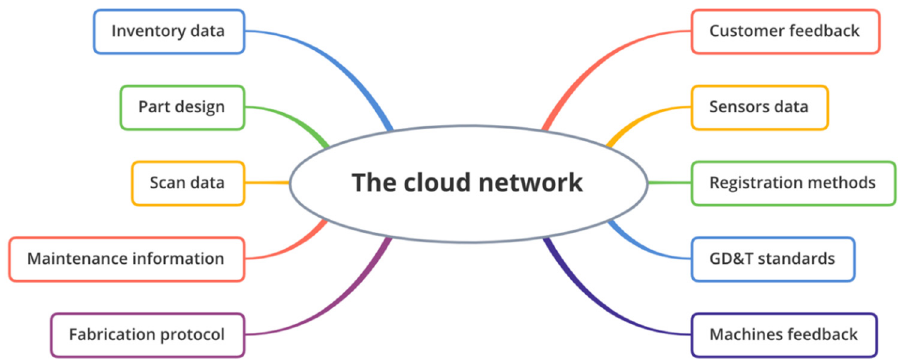
Figure 3. The cloud network in a 4.0 manufacturing factory.